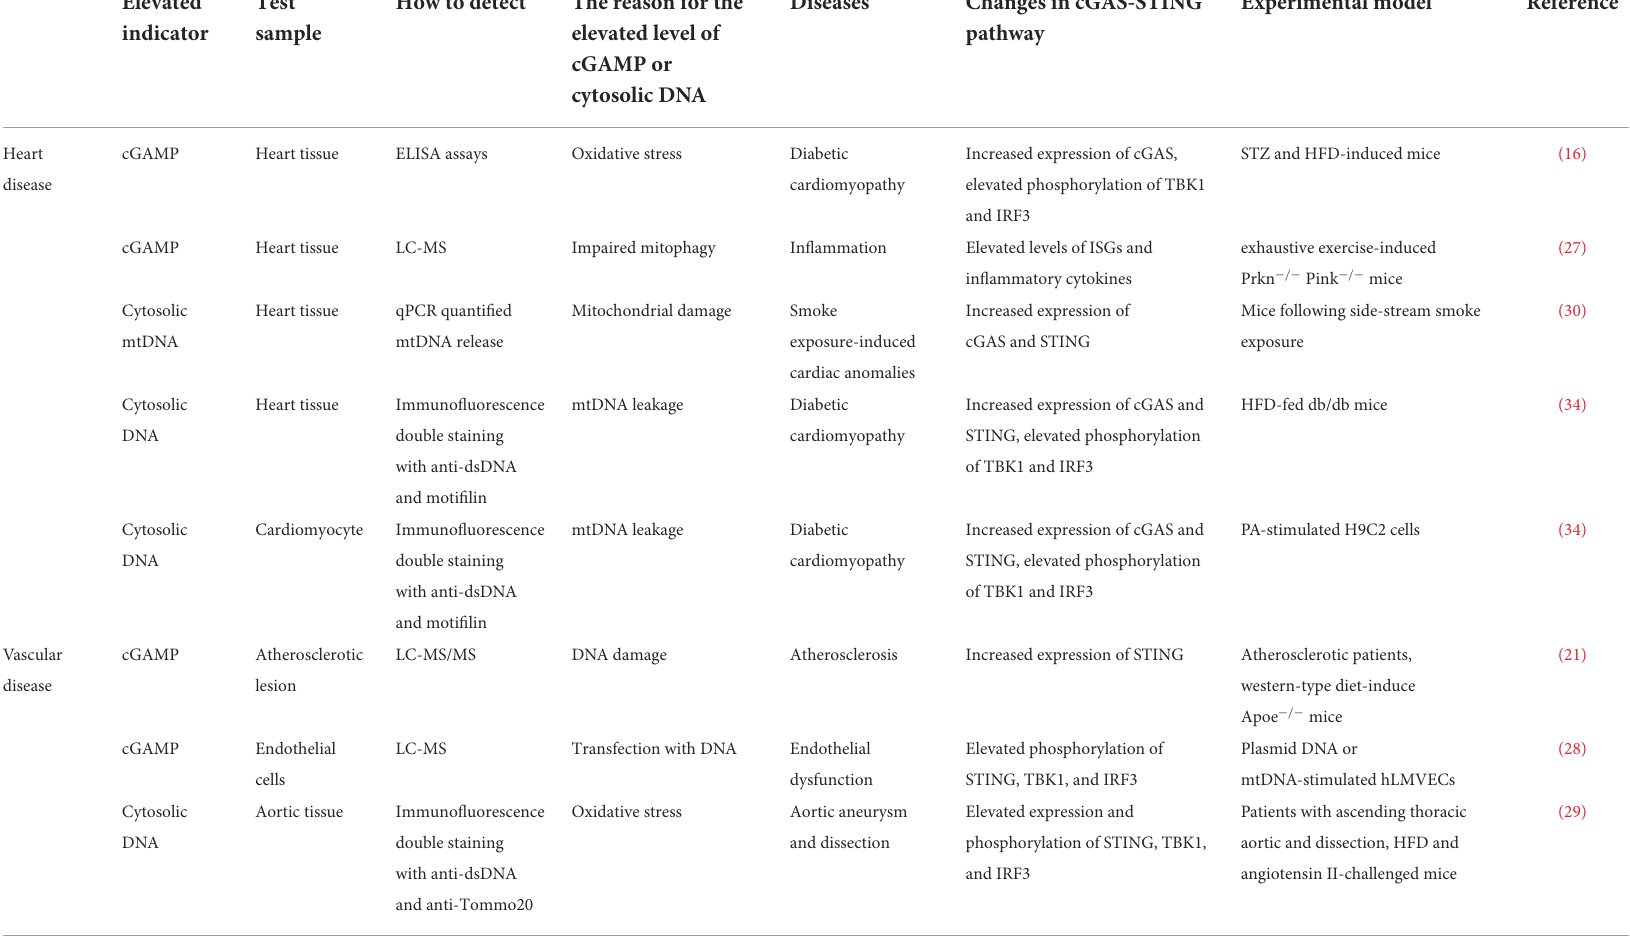
TABLE 1 cGAMP or cytosolic DNA was detected in experimental models of cardiovascular